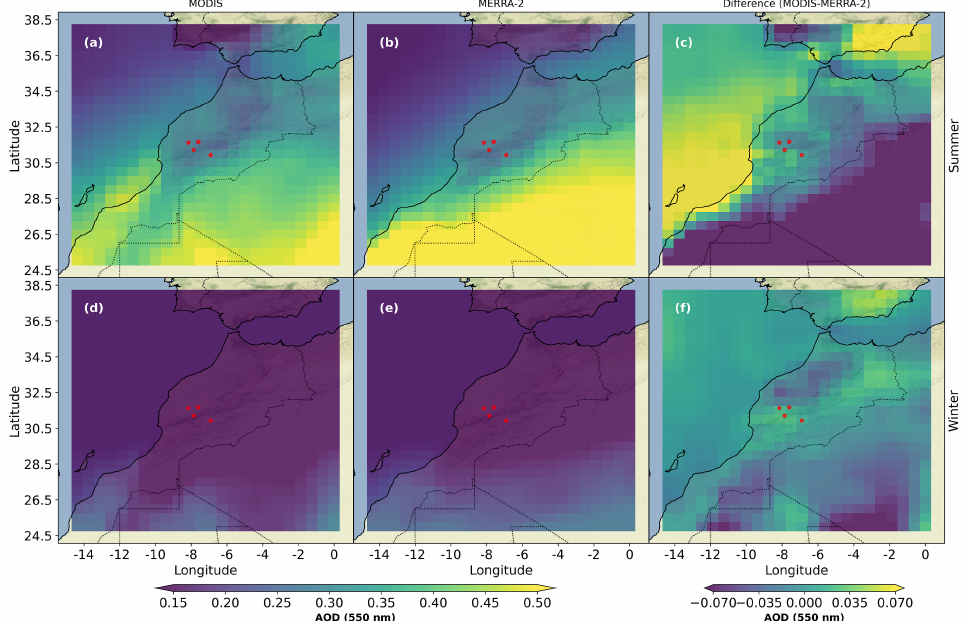
Figure 8. AOD 550 maps averaged for summer (JJA) and winter (DJF) from MODIS observations ( a , d ) and MERRA-2 reanalyses ( b , e ) over the 2000–2020 period. The rightmost column ( c , f ) indicates the difference, AOD MODIS -AOD MERRA − 2 , for each season. The study sites are indicated by the red dots, and the color scales are displayed at the bottom of the